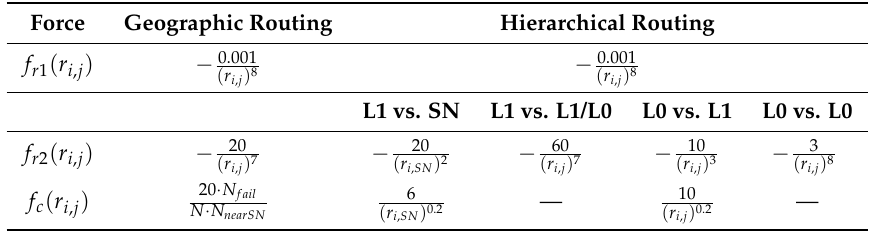
Table 1. Forces applied to node i for every node j in its